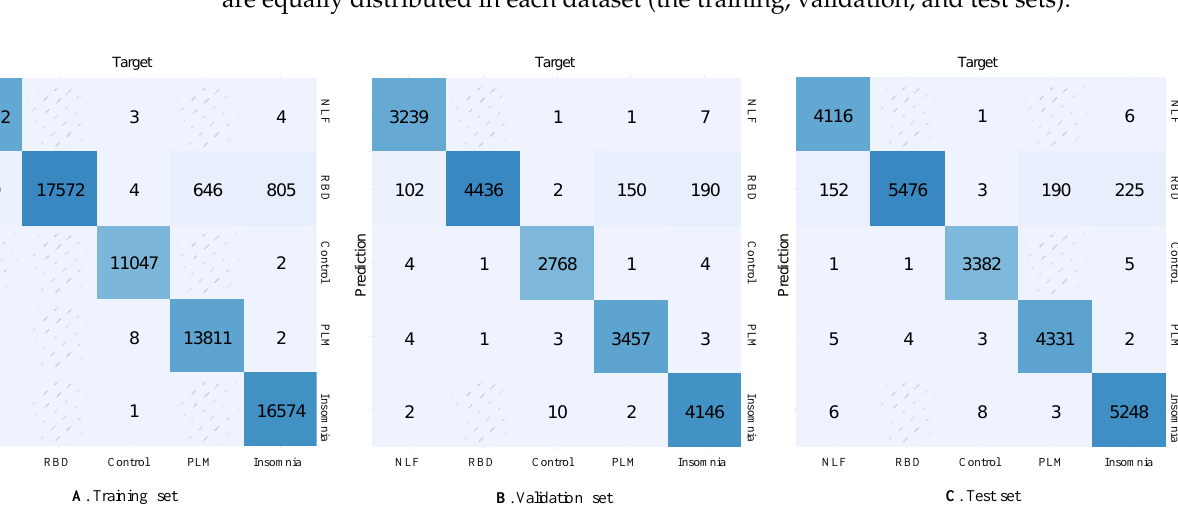
Figure 2. Confusion matrix of the proposed SDN model for the automatic classification of sleep disorders based on a single-lead ECG signal. The performances of the training set ( A ), validation set ( B ), and test set ( C ), respectively.